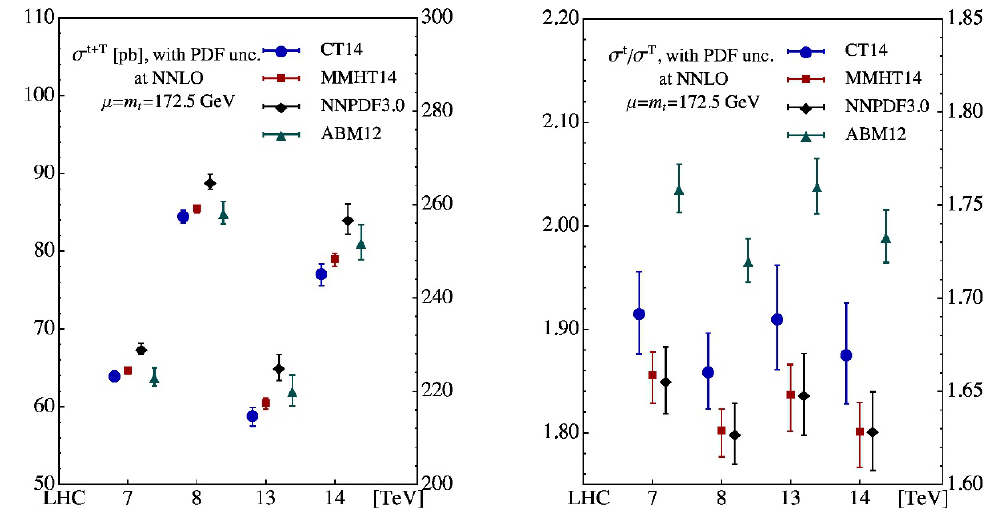
Figure 17 . Sum (left) and ratio (right) of inclusive cross sections for t -channel single top quark and anti-quark production, similar to (cid:12)gure 16.